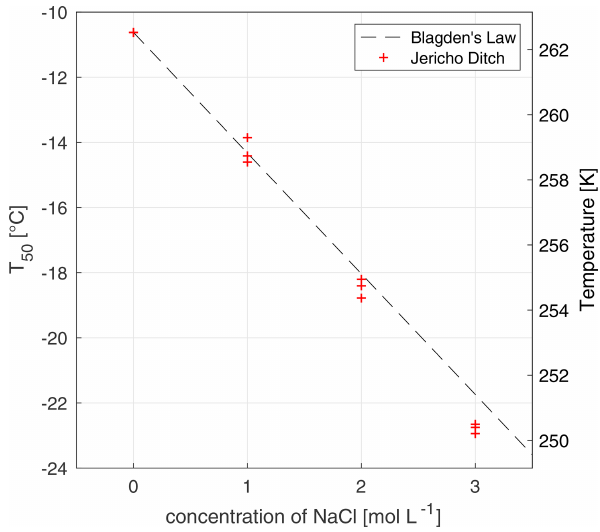
Figure 3. The freezing-point depression effect of solutions of 20mgCL − 1 of Jericho Ditch dissolved organic matter with in- creasing concentrations of sodium chloride (NaCl). The x axis rep- resents the concentration (molL − 1 ) of NaCl, and the y axis repre- sents the T 50 values, where 50% of the wells were frozen. Tripli- cate experiments were done for concentrations of 0, 1, 2, and 3M of NaCl, marked with red crosses. Note that the T 50 values for the ex- periments at 0molL − 1 are identical and thus overlap. Experimental data were compared to Blagden’s law (grey dashed line), which de- scribes the freezing-point depression phenomenon. All temperature measurements have an uncertainty of ± 0.5 ◦